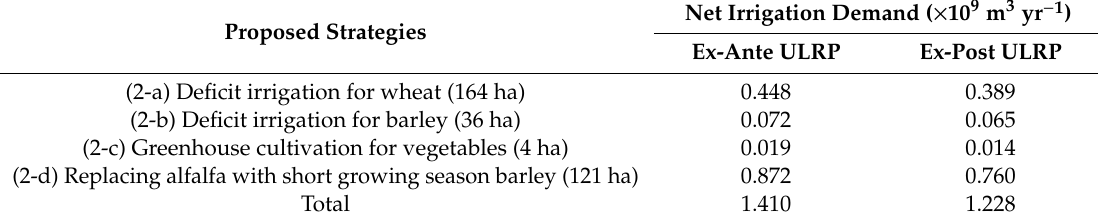
Table 1. The impact of the Urmia Lake Restoration Program (ULRP) Strategy #2 (enhancing crop water productivity) on the net irrigation demand. The average net irrigation demands for the covered area were estimated ex-ante (2000–2010) and ex-post (2020–2030) individually for Strategy #2 (2-a to 2-d).